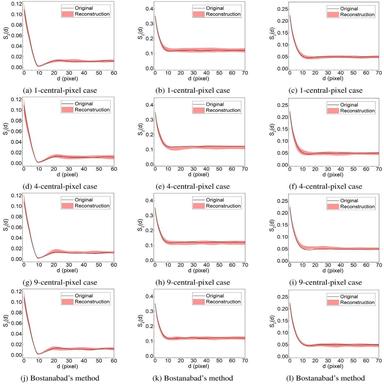
Comparison of TPCCF C2(d) between the original microstructures and the corresponding reconstructed microstructures from the proposed method and Bandstand's method.